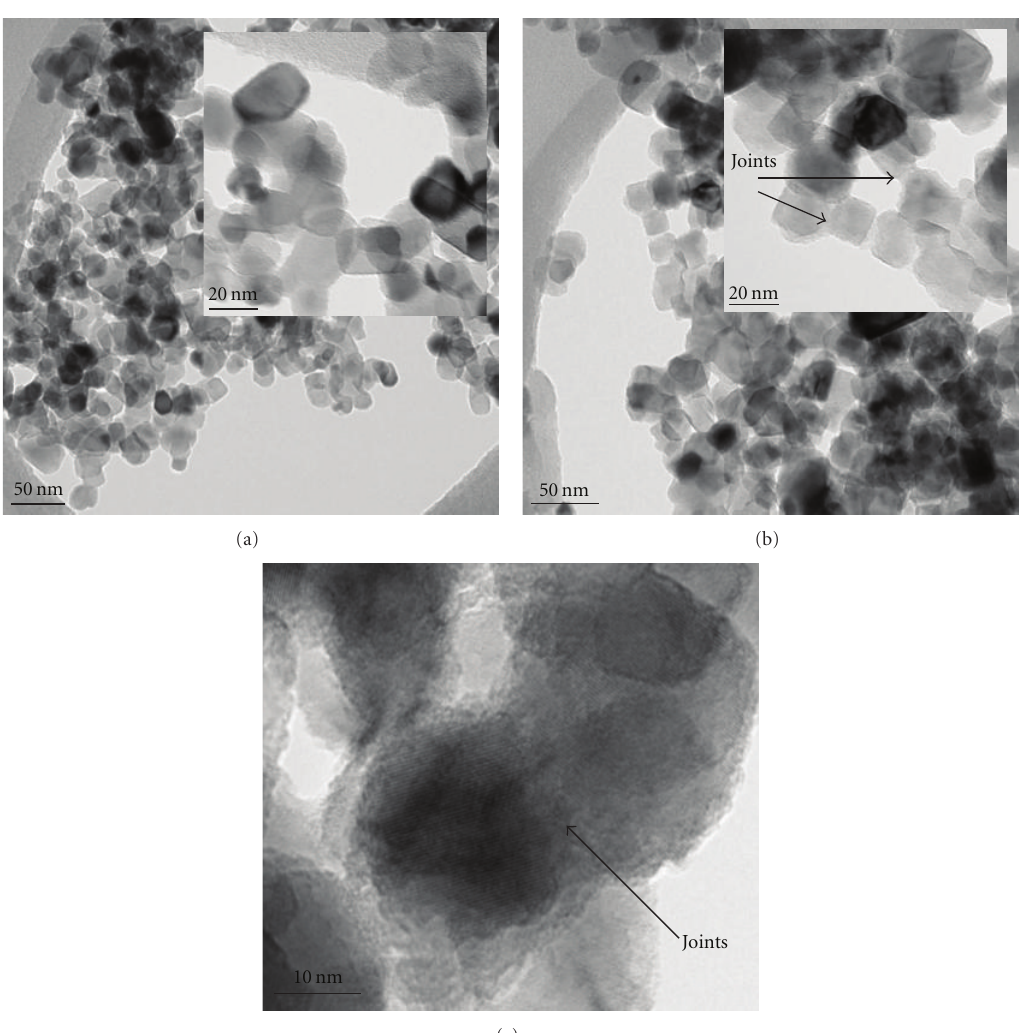
Figure 4: TEM images of TiO 2 films (a) without CIP and (b, c) with a CIP pressure of 200 MPa and holding time of 600s. The small inset shows the higher magnification image of each